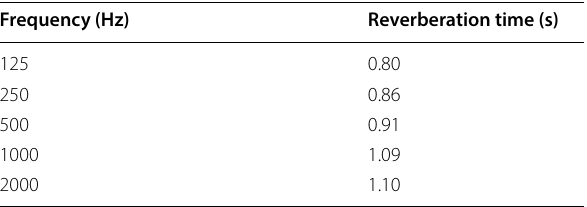
Table 4 Reverberation time of the receiver room for various frequencies.